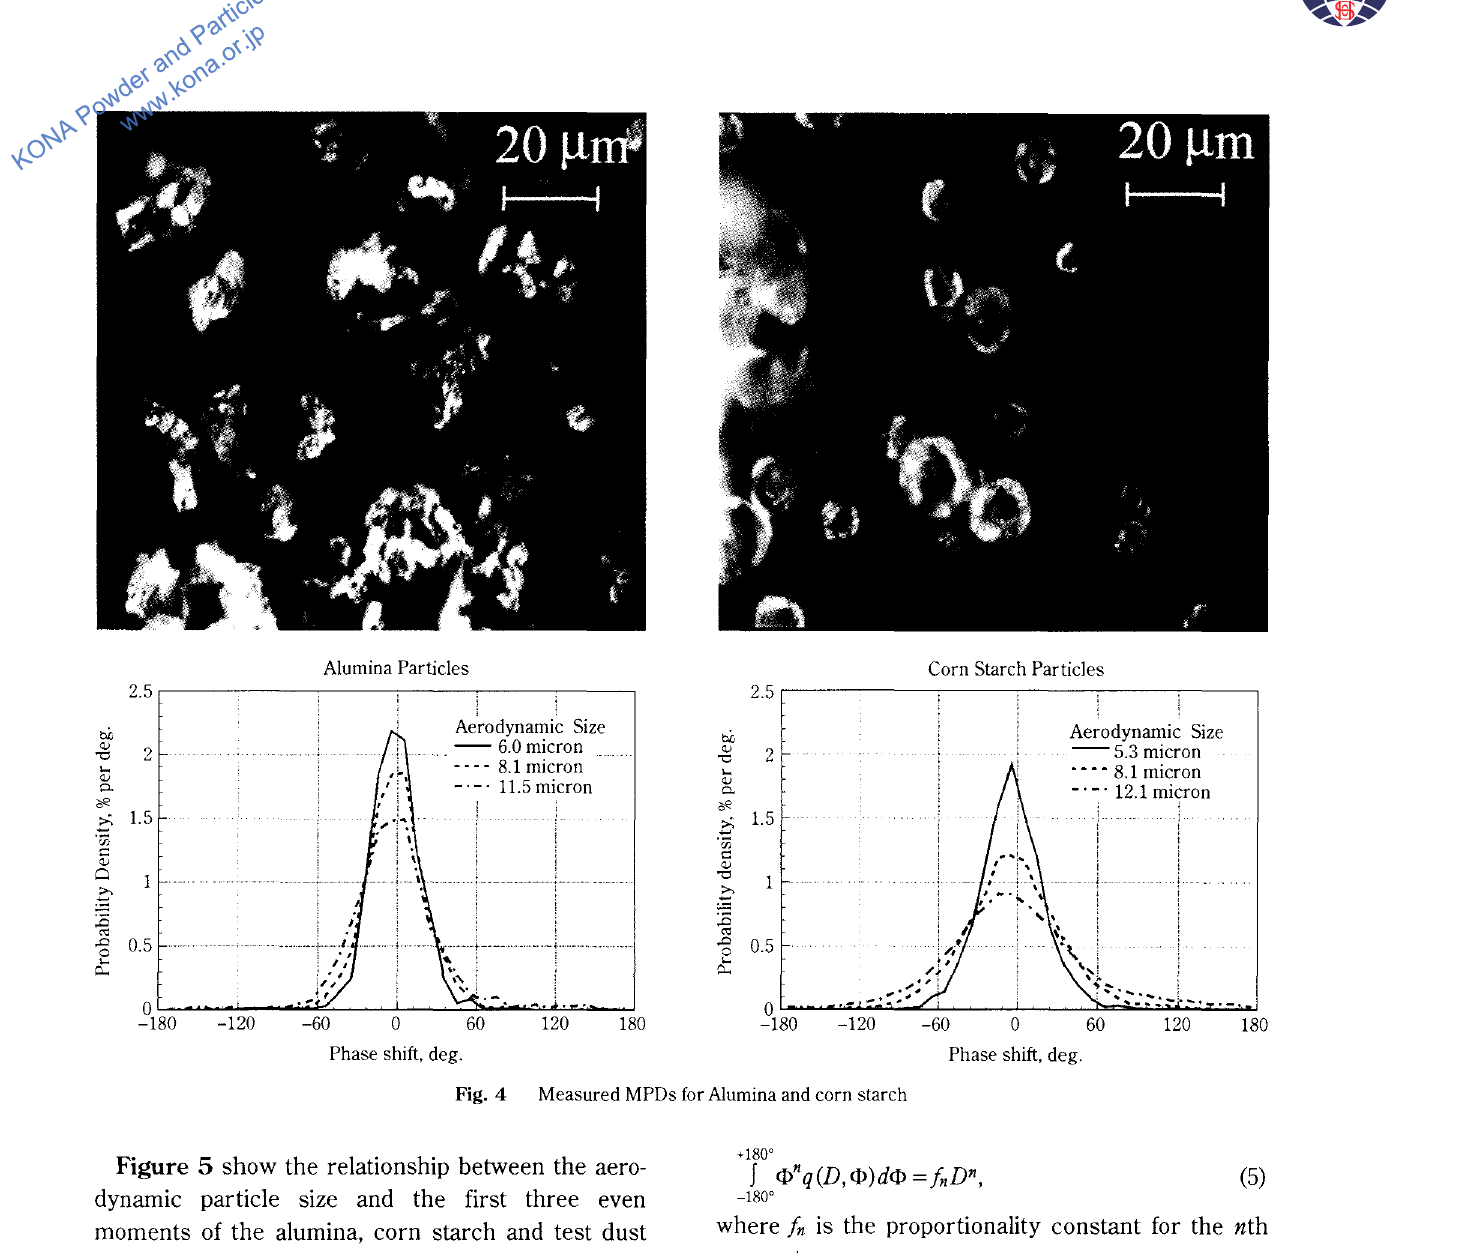
Fig. 4 Measured MPDs for Alumina and corn